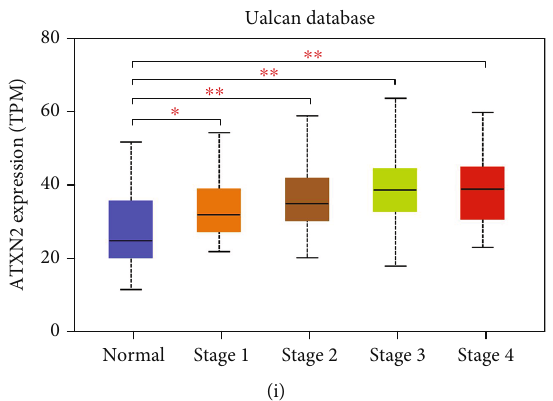
Figure 1: Identi fi cation of di ff erentially expressed genes between chemoresistant and chemosensitive cell lines. (a) Heatmap of the altered genes in SGC7901/ADR, SGC7901/VCR, and SGC7901/5-FU cells versus SGC7901 cells. (b, c) The di ff erentially upregulated (b) and downregulated (c) genes in chemoresistant cells. (e, f) The KEGG pathways for the downregulated (d) and upregulated (e) in chemoresistant cells. (f) The top 15 hub genes according to betweenness centrality, eccentricity, and stress algorithms. (g) ATXN2 expression in the GEPIA database and UALCAN database. (h) The association of ATXN2 expression with GC prognosis. (i) The association of ATXN2 expression with GC clinical stage. ∗ P < 0 : 05 and ∗∗ P < 0 : 01